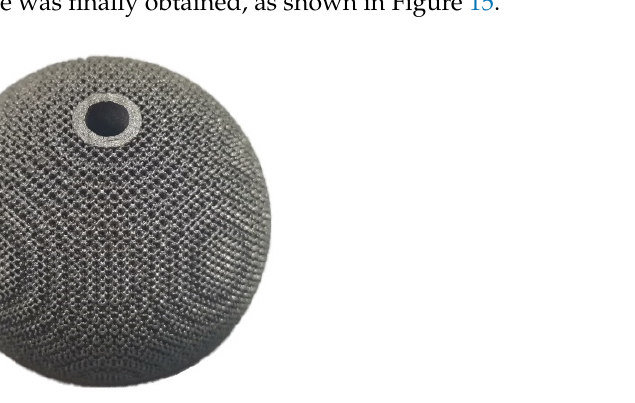
Figure 14. The deformation cloud diagrams of the acetabular cup under different forming angles: